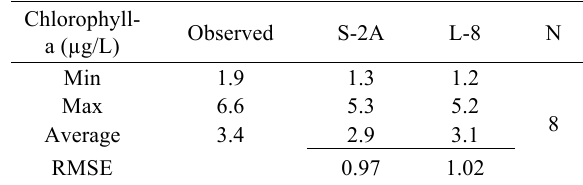
Table 1. Accuracy assessment of satellite-derived chlorophyll-a